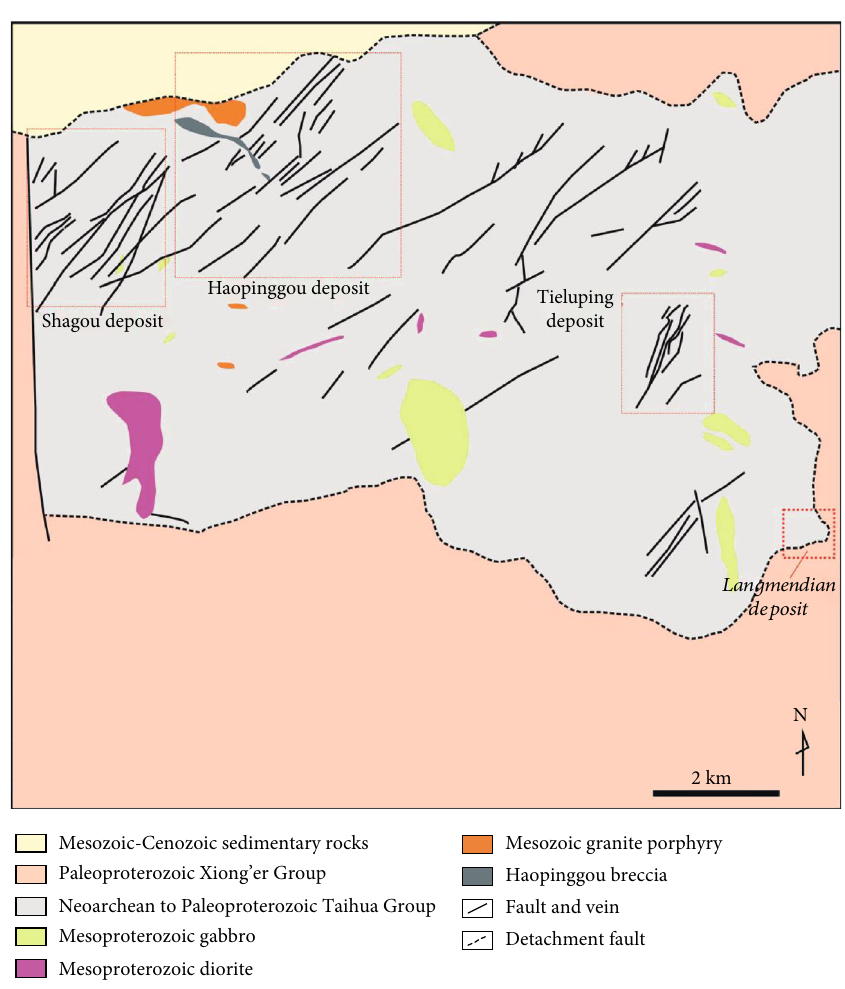
Figure 2: Geologic map of the Shagou (Xiayu) Ag-Pb-Zn ore fi eld (modi fi ed from